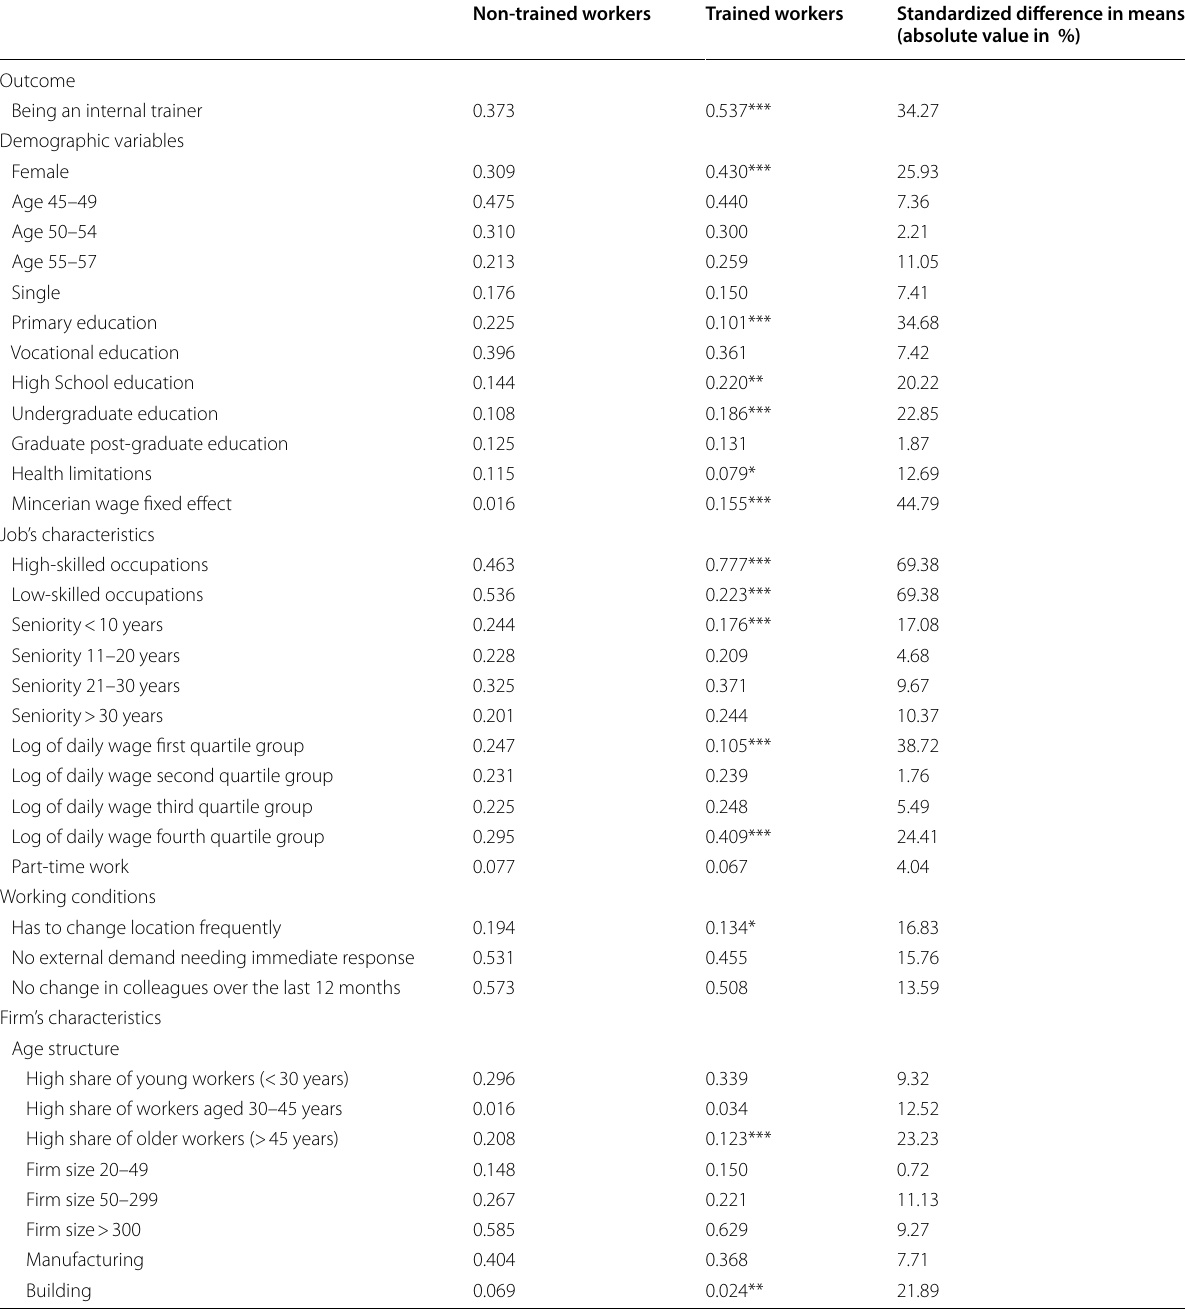
Table 5 Descriptive statistics of workers according to their participation in a training program regarding the use of new ICT tools Non-trained workers Trained